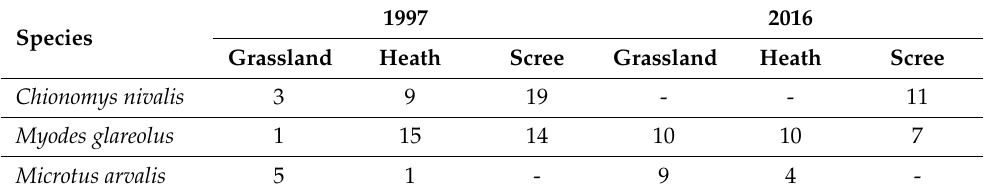
Table 1. Contingencies of the three rodent species across years and habitat types. 1997 2016 Species Grassland Heath Scree Grassland Heath Scree Chionomys nivalis 3 Myodes glareolus 1 Microtus